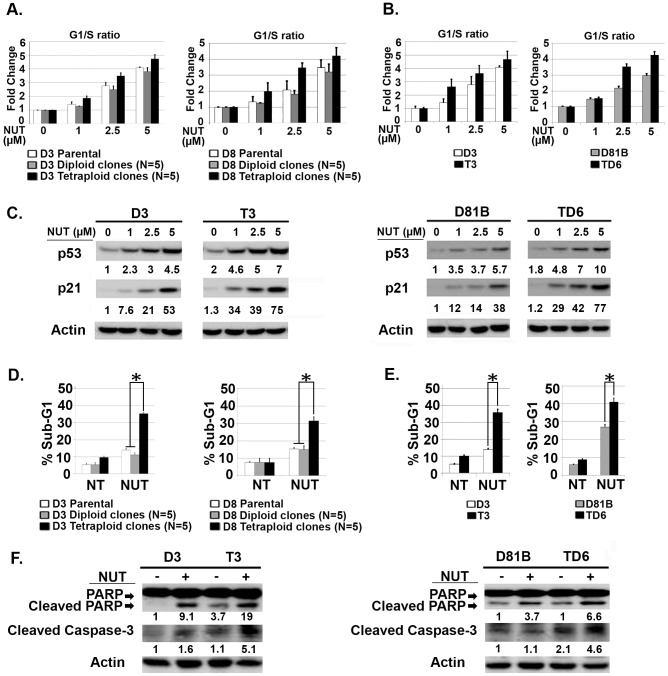
Tetraploid clones are more susceptible to Nutlin-induced cell cycle arrest and apoptosis.
A) Five diploid clones isolated from Nutlin treated D3 cells (D3 Diploid) and D8 cells (D8 Diploid), and five tetraploid clones isolated from Nutlin treated D3 cells (D3 Tetraploid) and D8 cells (D8 Tetraploid) were untreated or treated with increasing Nutlin (1.0–5.0 µM) for 24 hrs. The percent G1 and S-phase cells was determined by flow cytometry, and the fold change of G1/S ratio is plotted. Untreated diploid clones G1/S ratio was given a value of 1.0. Shown is the average of three separate experiments, +/- SE. B) Tetraploid clones (T3, TD6) and diploid counterparts (D3, D81B) were untreated or treated with Nutlin (1.0–5.0 µM) for 24 hrs. The fold change of G1/S ratio is plotted. Shown is the average of three separate experiments, +/- SE. C) Diploid (D3, D81B) and tetraploid (T3, TD6) clones were untreated or treated with increasing Nutlin (1.0–5.0 µM) 24 hrs. P53 and p21 protein levels were quantified using Image-J software. Numbers indicate the relative levels of each protein. P53 and p21 levels in untreated diploid clones was given a value of “1.0”. Actin was used as loading control. D) Five diploid clones isolated from Nutlin treated D3 cells (D3 Diploid) and D8 cells (D8 Diploid), and five tetraploid clones isolated from Nutlin treated D3 cells (D3 Tetraploid) and D8 cells (D8 Tetraploid) were untreated (NT) or treated with Nutlin (20 µM) 72 hrs and apoptosis determined. Shown are the mean results from three separate experiments, bars, Standard error (SE). *(P<0.05). E) Representative diploid (D3, D81B) and tetraploid (T3, TD6) clones were untreated (NT) or treated with Nutlin (20 µM) for 72 hrs. The percentage of cells with sub-G1 DNA content (propidium iodide staining) was determined. Shown are the mean results from three separate experiments, bars, Standard error (SE). * significance value (P<0.05). F) The indicated diploid and tetraploid clones were untreated (NT) or exposed to Nutlin (20 µM) for 48 hrs. Cleaved PARP and Caspase-3 protein levels were determined by immunoblotting and quantified relative to the untreated.